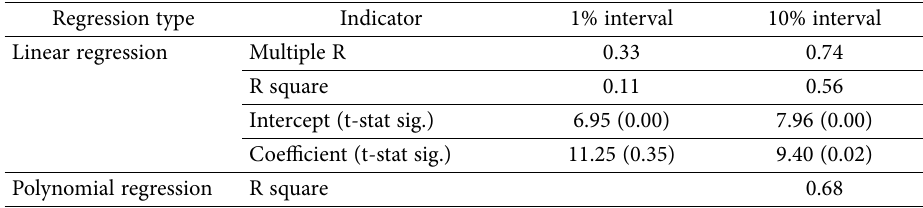
Table 6A. Regression statistics of profit margin